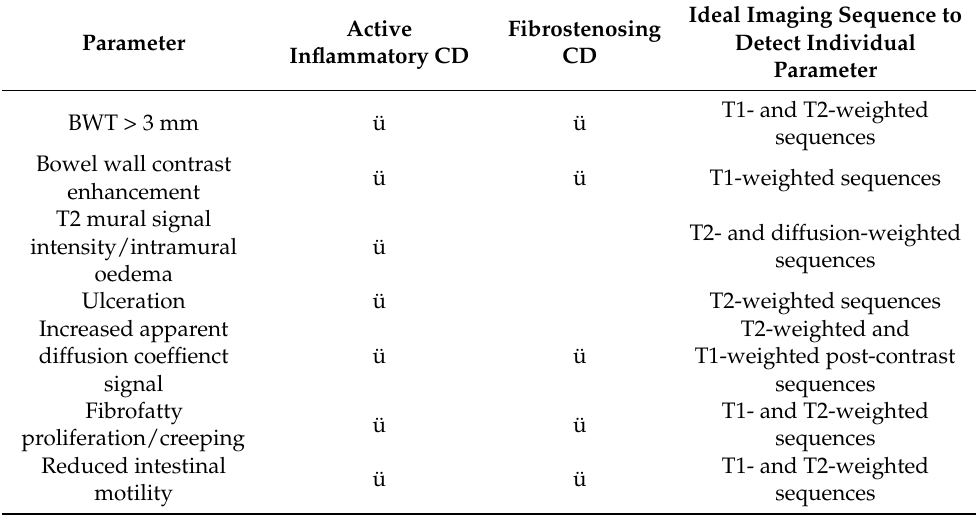
Table 1. Differentiating MRE parameters between inflammatory and fibrostenosing